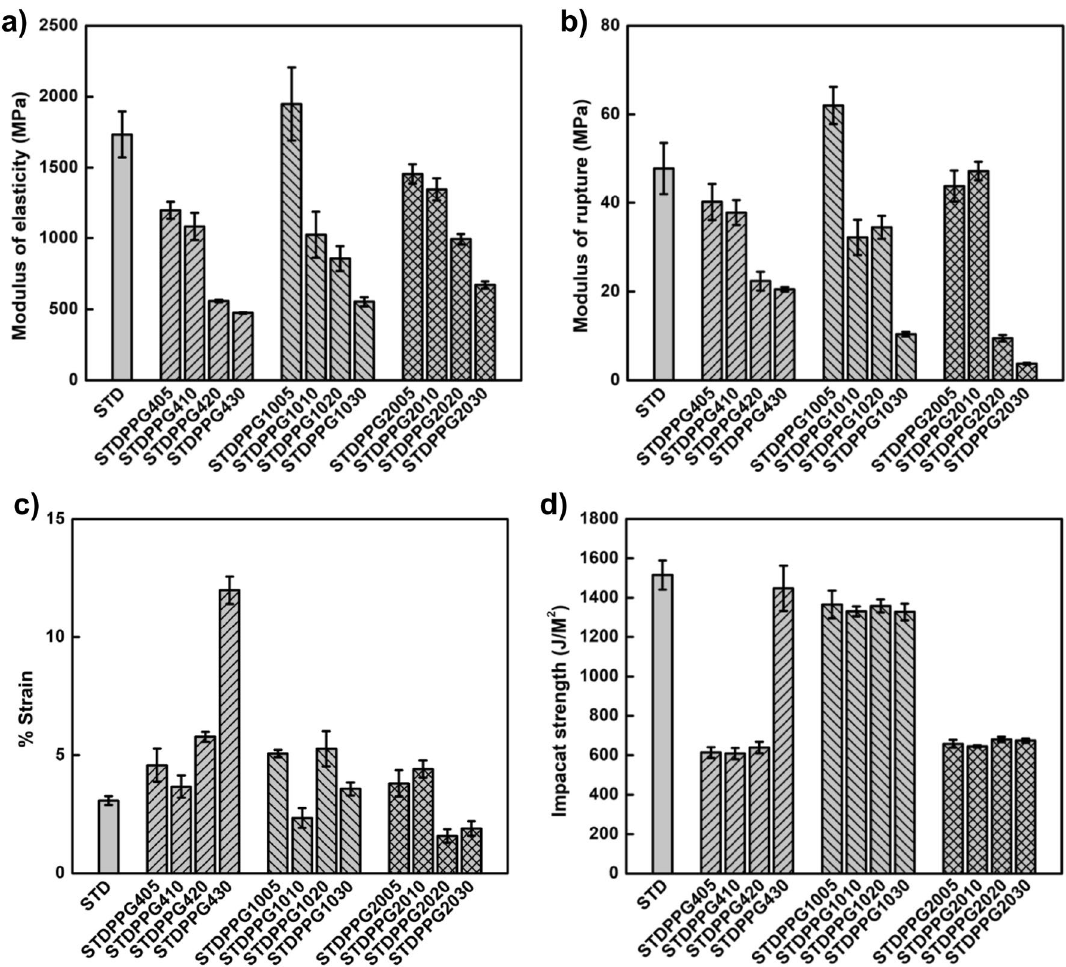
Figure 6. Mechanical properties of the printed STD and formulated resins; ( a ) modulus of elasticity, ( b ) modulus of rupture, ( c ) flexural strain, and ( d ) impact strength.